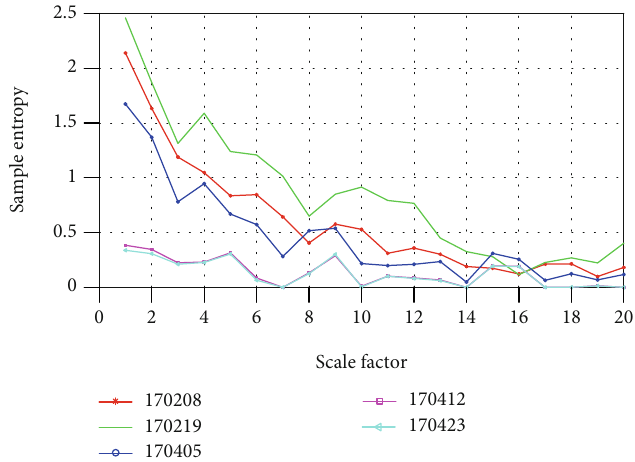
Figure 4: MSE analysis of the GWTC-1-marginal interval data recorded by H1 observatory.